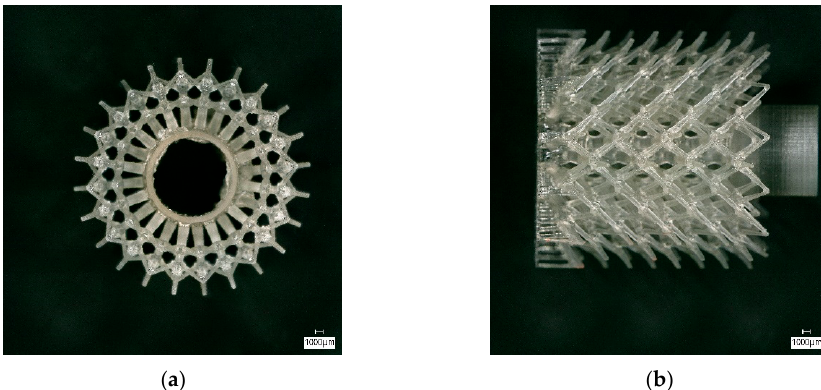
Figure 12. Complex structured polymeric template: top view ( a ) and side view of generated polymeric template by stereo lithography ( b ).